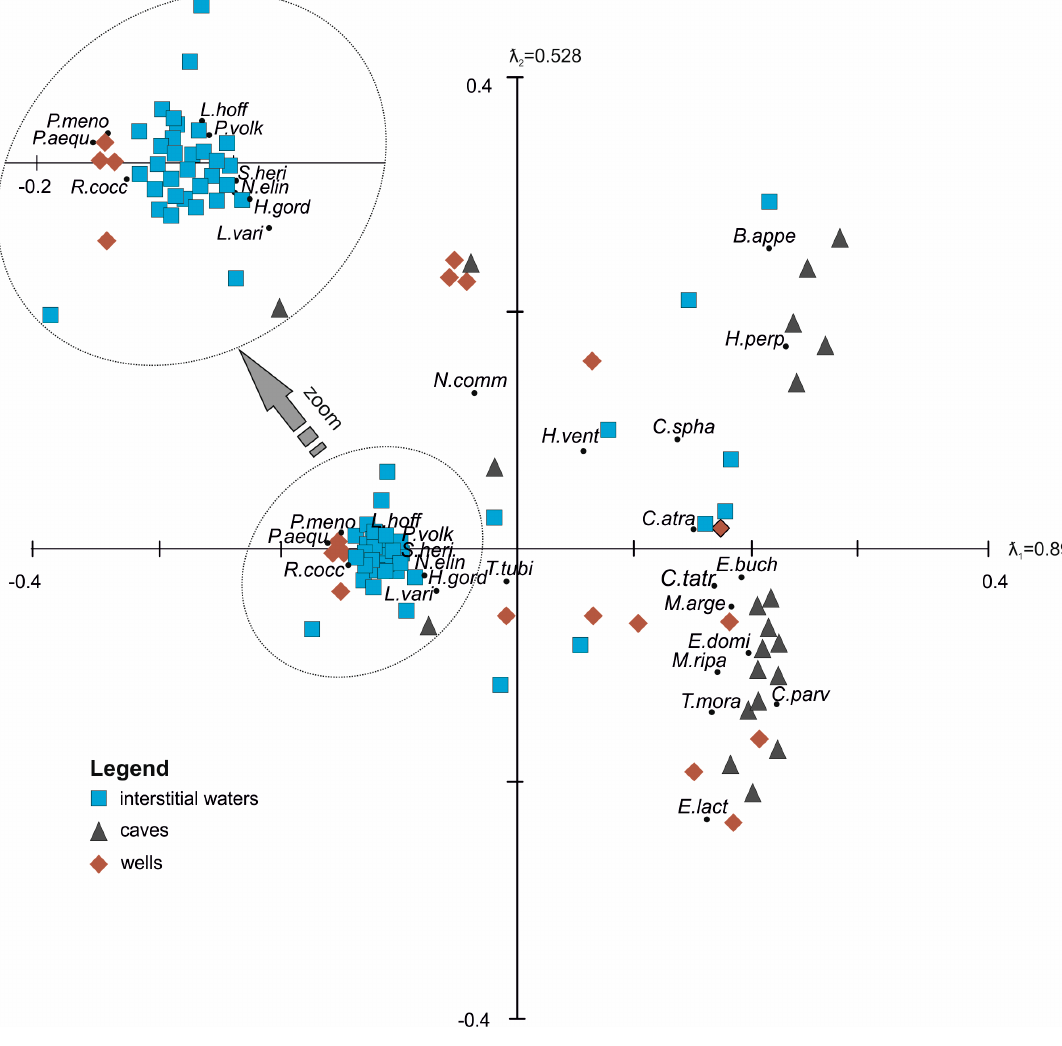
Figure 3. Correspondence analysis (CA) ordination diagram with both samples and species plotted.